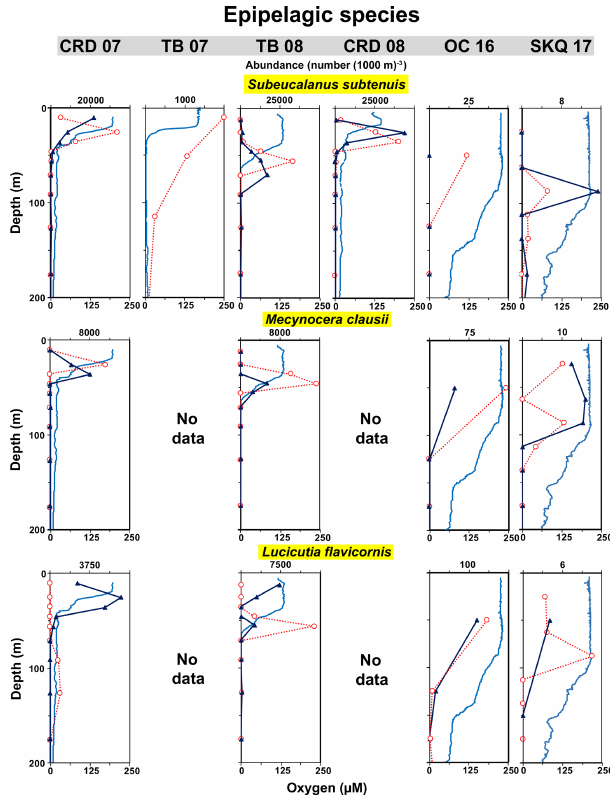
Figure 10. Vertical distributions relative to oxygen: epipelagic species. Each row is a different species. The depth axis for these graphs is 0–200m. The uppermost point in the graphs includes the sampling interval that extends to the sea surface (plotted at the mid- depth of the interval). See Fig. 3 caption for more